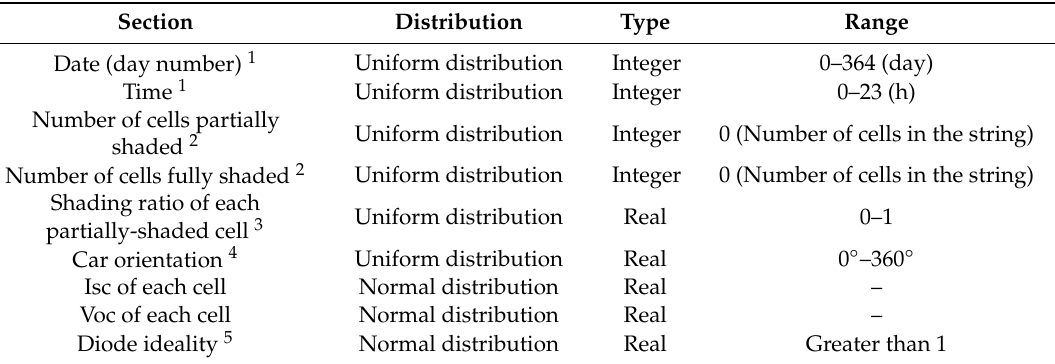
Table 1. Summary of random variables used for the Monte Carlo